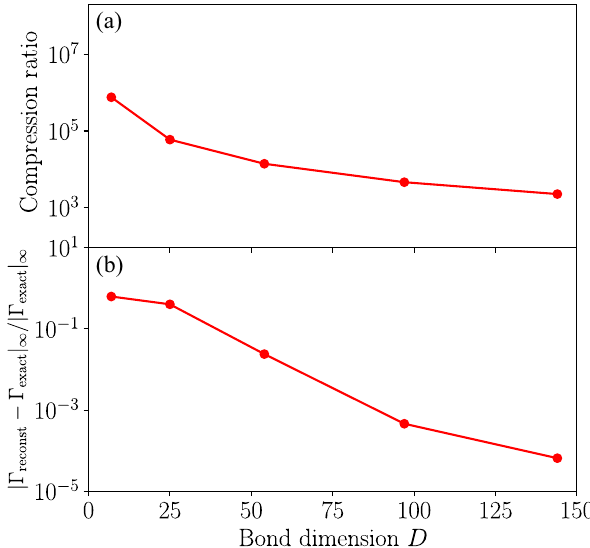
FIG. 15. Dependence of (a) compression ratio and (b) error (accuracy) on the bond dimension for Γ of the Hubbard atom at d U ¼ 3 ( β ¼ 1 ). We compress the data on a 2 R × 2 R × 2 R grid with R ¼ 10 using the cutoffs ϵ ¼ 10 − 6 , 10 − 8 , 10 − 10 , 10 − 12 , and 10 − 14 . The symbol j (cid:2) (cid:2) (cid:2) j ∞ denotes the maximum norm of a tensor, which is the maximum of the absolute values of its elements. Figure 17(a) illustrates the MPS used for compressing the local generalized susceptibility. A fermionic frequency ν is encoded as described in Sec. II C. The combined indices for the j ¼ 5 = 2 multiplet I and J are not decom- posed further in this study. Figures 17(b) and 17(c) show the results for ð I; J Þ ¼ ð 1 ; 1 Þ and (1,36), respectively. The left panels plot the reconstructed data from the MPS constructed with ϵ ¼ 10 − 8 and R ¼ 7 ( N ¼ 128 ), while w the right panels show the error. In Fig. 17(b), one sees broad structures in addition to the diagonal line at ν ¼ ν 0 . A similar but weak broad structure is also seen in Fig. 17(c).